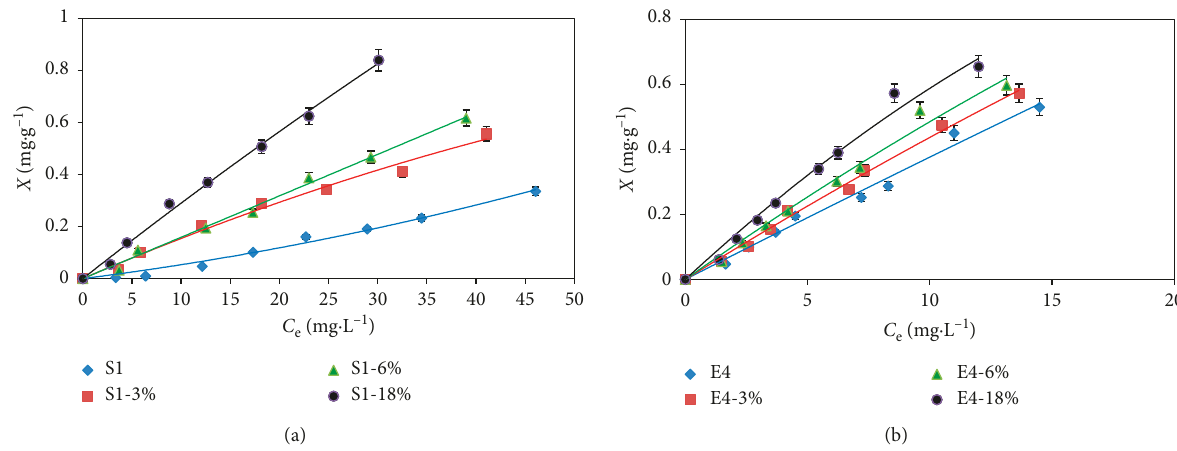
Figure 1: Penconazole adsorption isotherms on original and amended S1 (a) and E4 (b) soil samples.